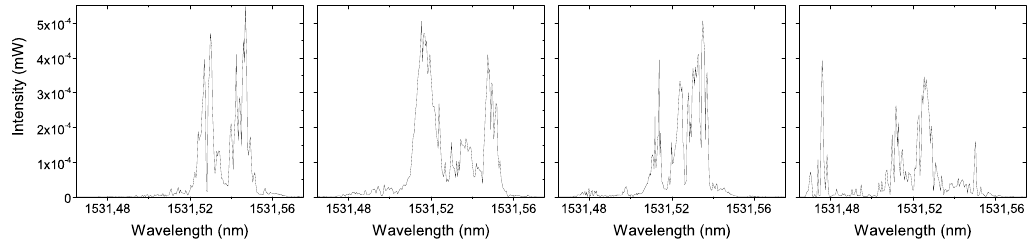
Figure 5. Temporal and spectral random behavior in the region of highest erbium emission profile, for four consecutive measurements.